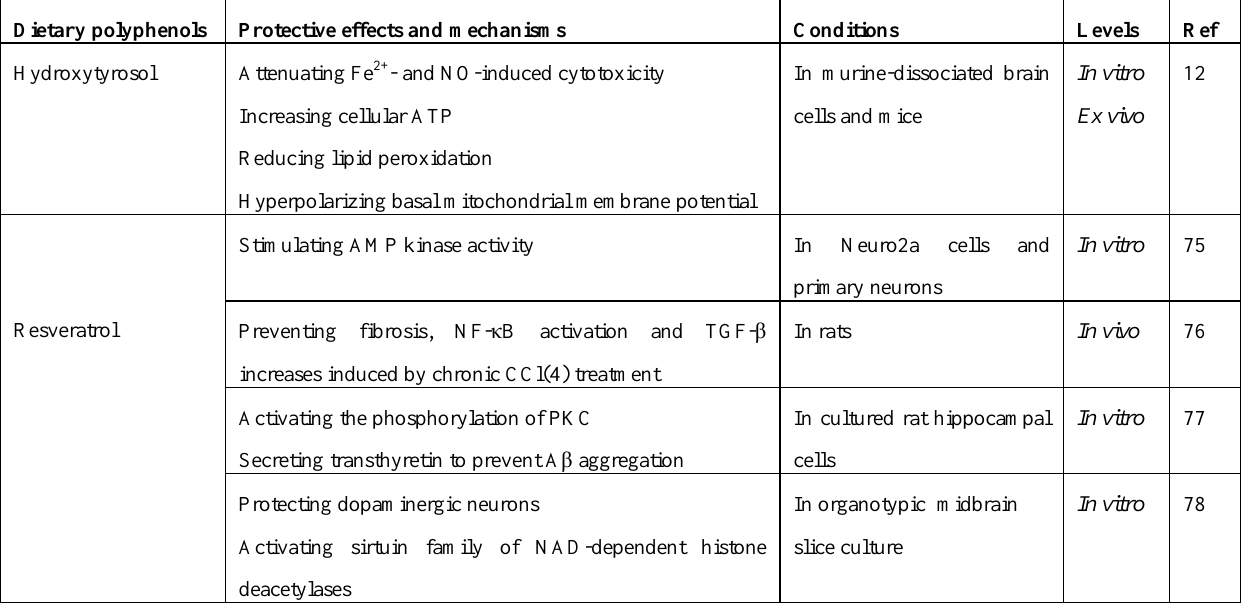
Table 4. Neuroprotective effects of dietary